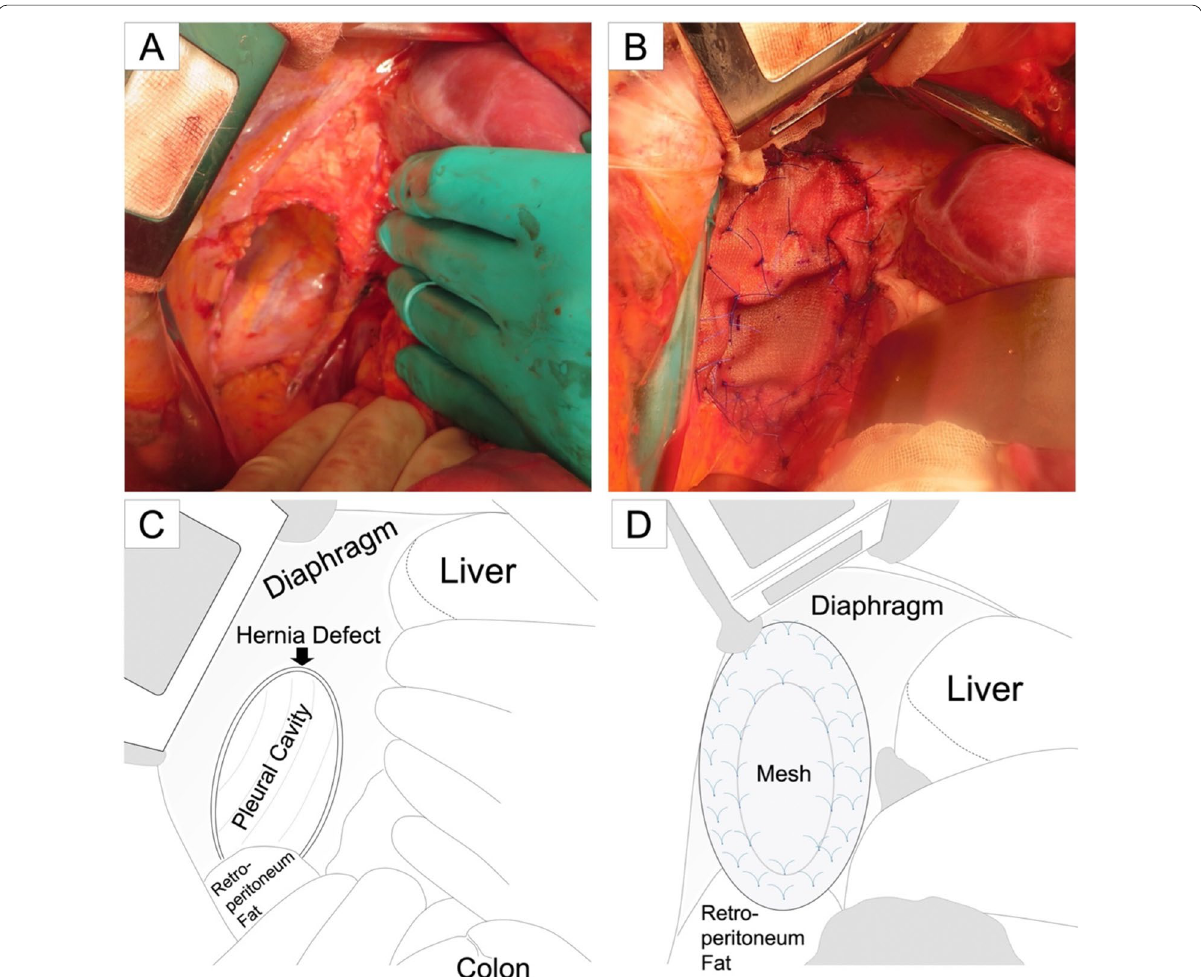
Fig. 5 Intraoperative photographs. a Distal part of the duodenum, ileum, jejunum, the right part of the colon, and the right kidney were reduced into the abdominal cavity consecutively. The defect was exposed on the posterolateral portion of the diaphragm, as predicted. b Large oval defect was closed with monofilament polypropylene mesh. c Schematic illustration of the photograph A. d Schematic illustration of the photograph B